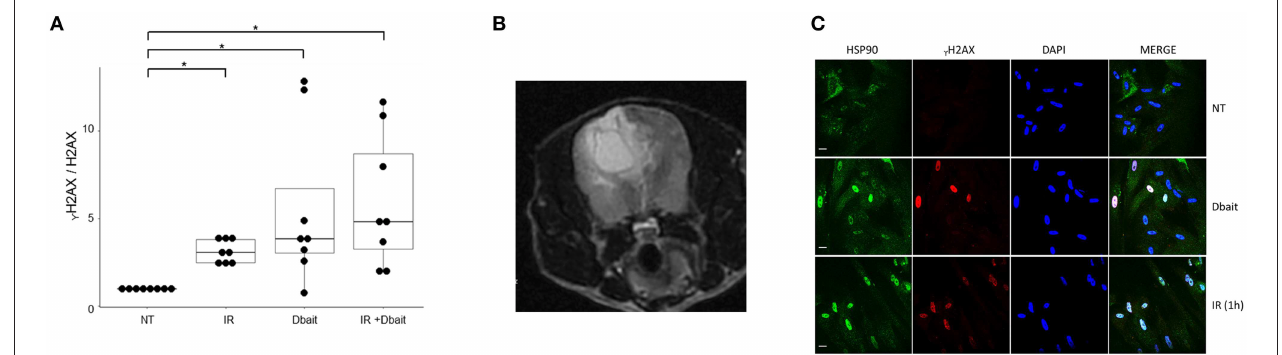
FIGURE 2 | g H2AX induction in gliomas cells after Dbait treatment. (A) g H2AX induction in human gliomas cell lines after Dbait treatment. The nine glioma cell lines were untreated (NT), irradiated (IR, 10Gy), treated with Dbait (5h) or treated with Dbait and irradiated. One hour after treatment completion, total proteins were electrophoresed followed by immunobloting. The blots were analyzed using the Odyssey Infrared Imaging System (LI-COR Biosciences) and Odyssey software. The induction of g H2AX ( g H2AX on H2AX ratio) is presented. Mann-Whitney test was performed (* p < 0.05). (B) MRI of a boxer dog with a spontaneously brain tumor.